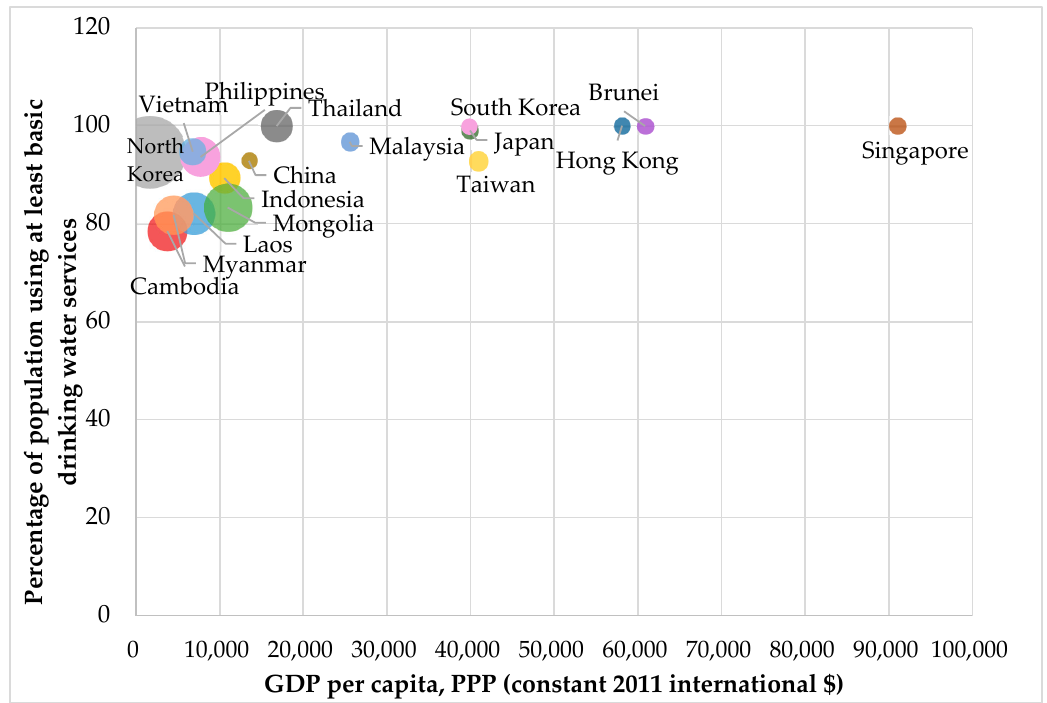
Figure 9. Relationship between GDP per capita, the percentage of population using at least basic drinking water services, and prevalence of undernourishment in East and Southeast Asian economies 2017 (The area of each bubble signifies the prevalence of undernourishment in each country). (Source: data retrieved from [4]). Note: according to [4], data on the 2.5% prevalence of undernourishment denotes ‘2.5% and below’.